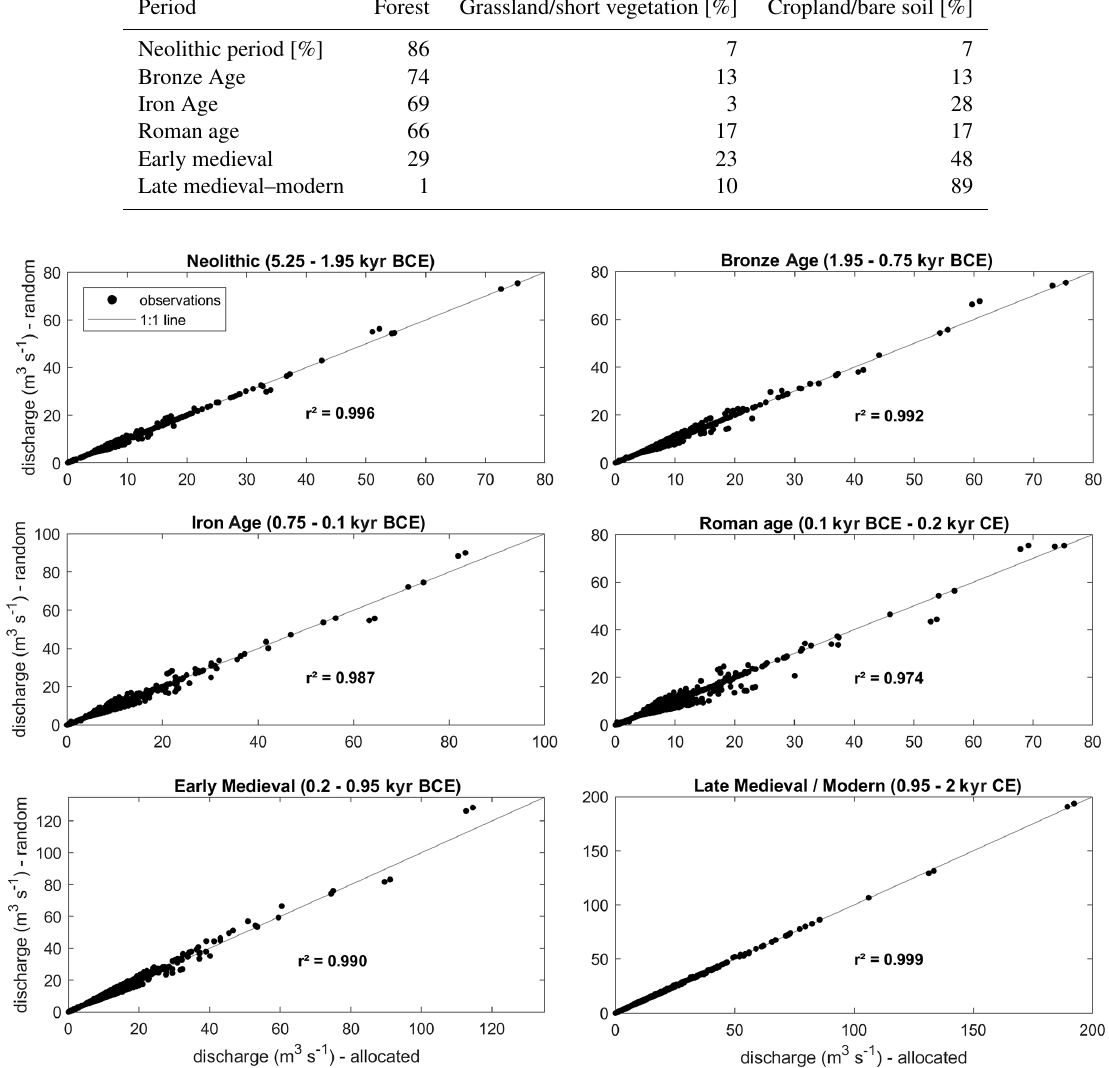
Table A5. Vegetation fractions of the land cover maps of the Dijle catchment, used for the different archaeological periods. Period Forest Grassland/short vegetation [%] Cropland/bare soil [%]